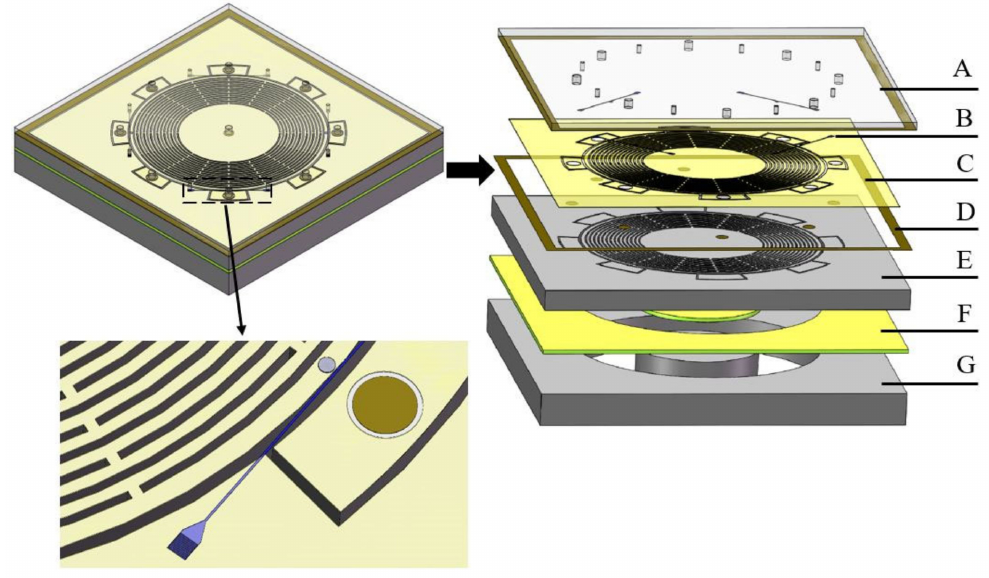
Figure 15. 3-D structure of the MOEMS